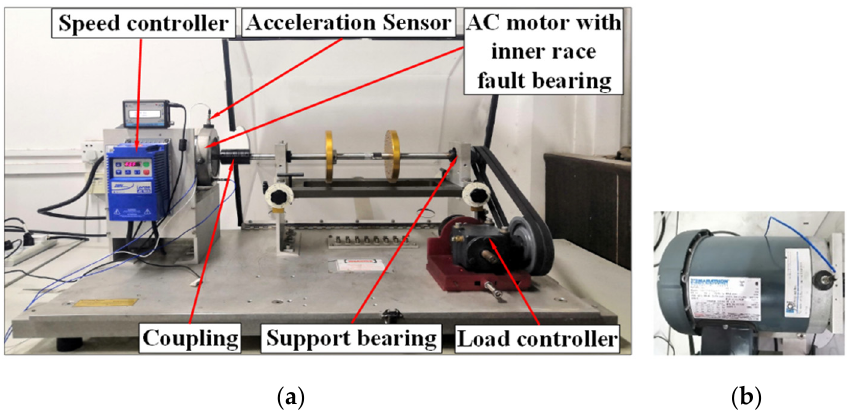
Table 1. Technical details of the acceleration sensor.